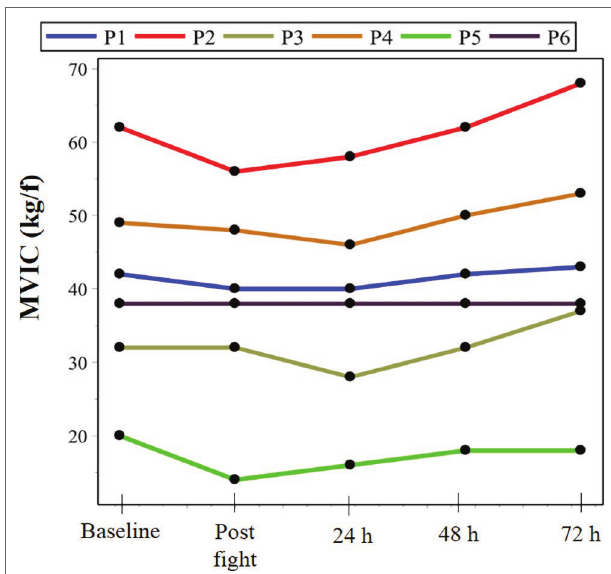
FIGURE 4 | Functional outcomes, represented by isometric strength analysis. MVIC, maximum voluntary isometric contraction; P, parathlete. Parathletes I and II were world champions in their respective